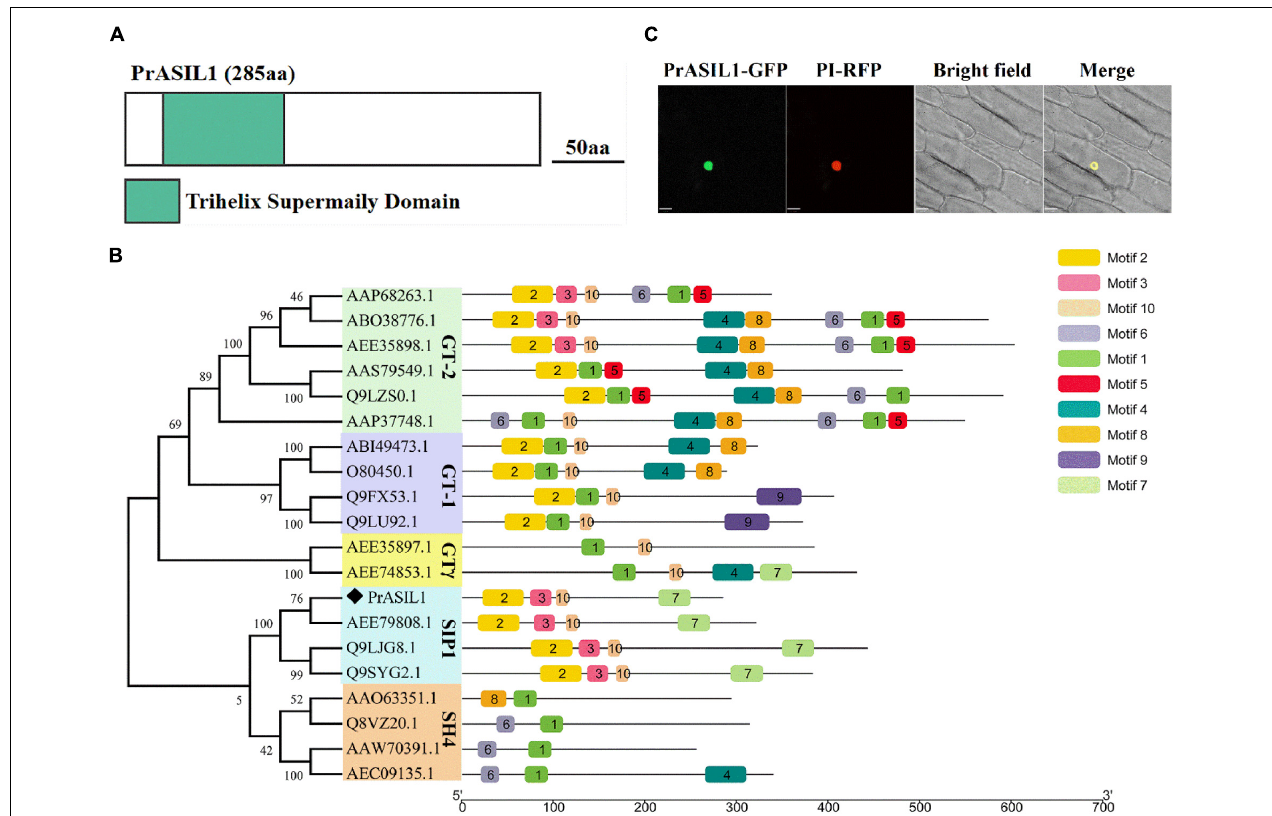
FIGURE 2 | Molecular characterization of PrASIL1. (A) Schematic representation of PrASIL1 structure. aa, Amino acids. (B) Phylogenetic tree and conserved motifs of the PrASIL1. (C) Subcellular localization of the PrASIL1 protein fused with GFP ( 35S:PrASIL1 - GFP ) in onion epidermal cells. Bars = 33 µ